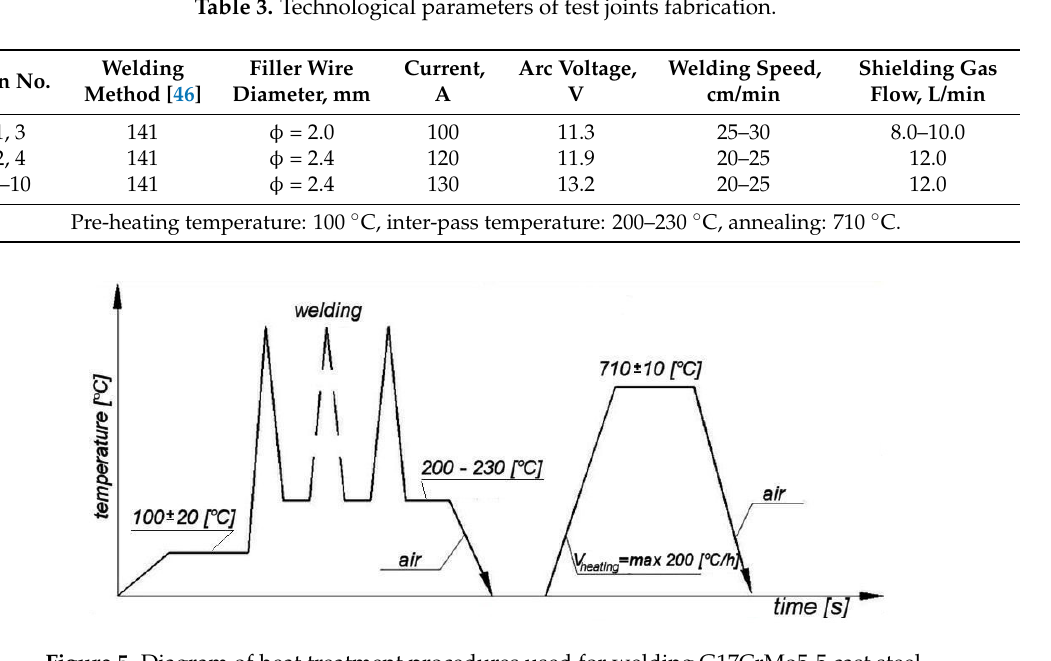
Table 2. Mechanical properties of G17CrMo5-5 cast steel.